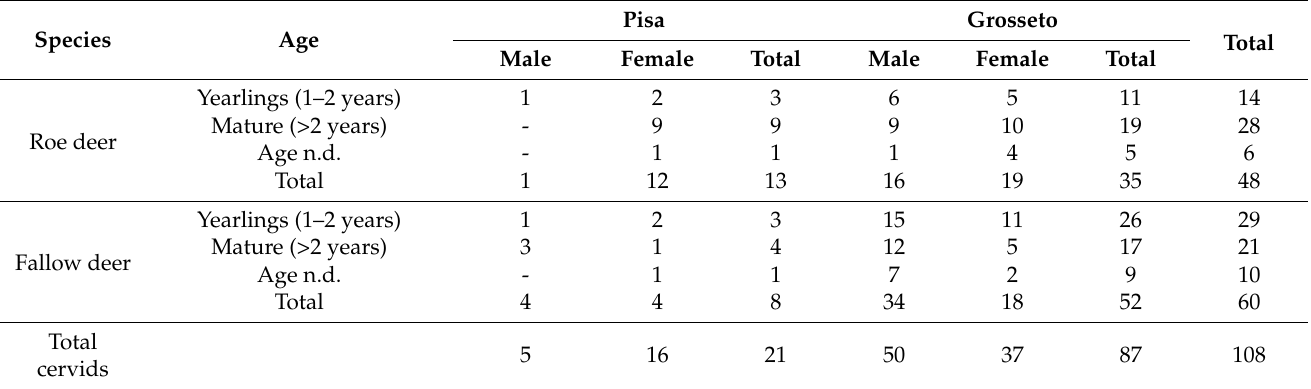
Table 2. Number of animals sampled in this study sorted by species, province of origin, sex, and age. N.d. = not determined.